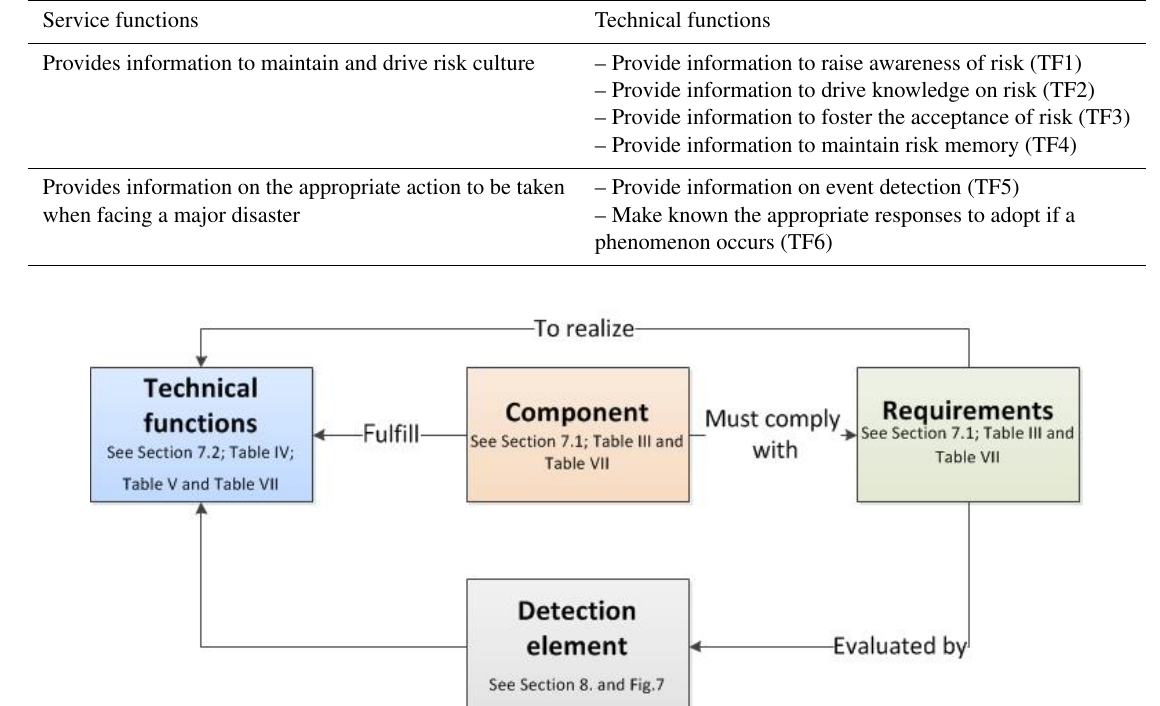
Table 4. List of technical functions identified for both service functions of DICRIM.